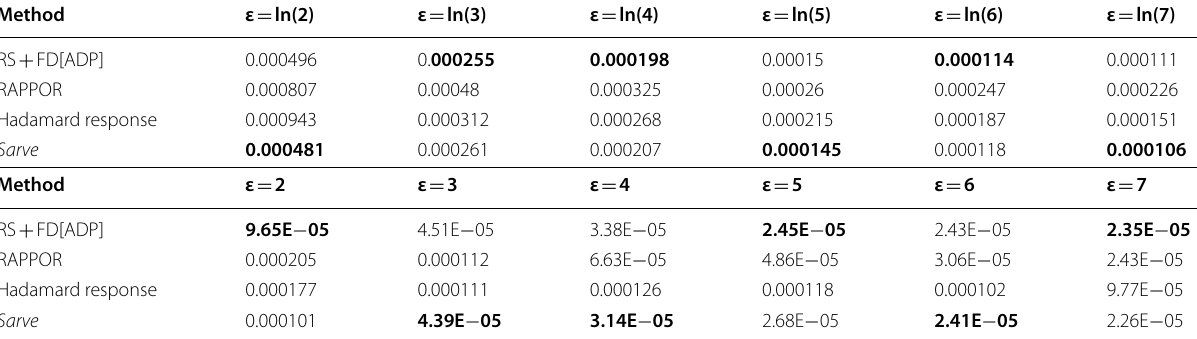
Table 6 The lowest MSE for the existing method and the enhancements which were tested on a synthetic 10-dimensional dataset having 50,000 records